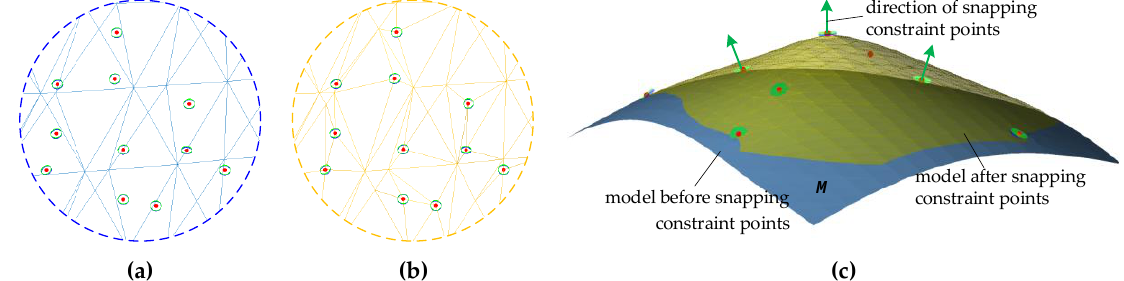
Figure 4. Snap constraint points. ( a ) shows the mesh before snapping of the constraint points. ( b ) shows the mesh after snapping of the constraint points. ( c ) shows the influence of snapping constraint points on the mesh model.